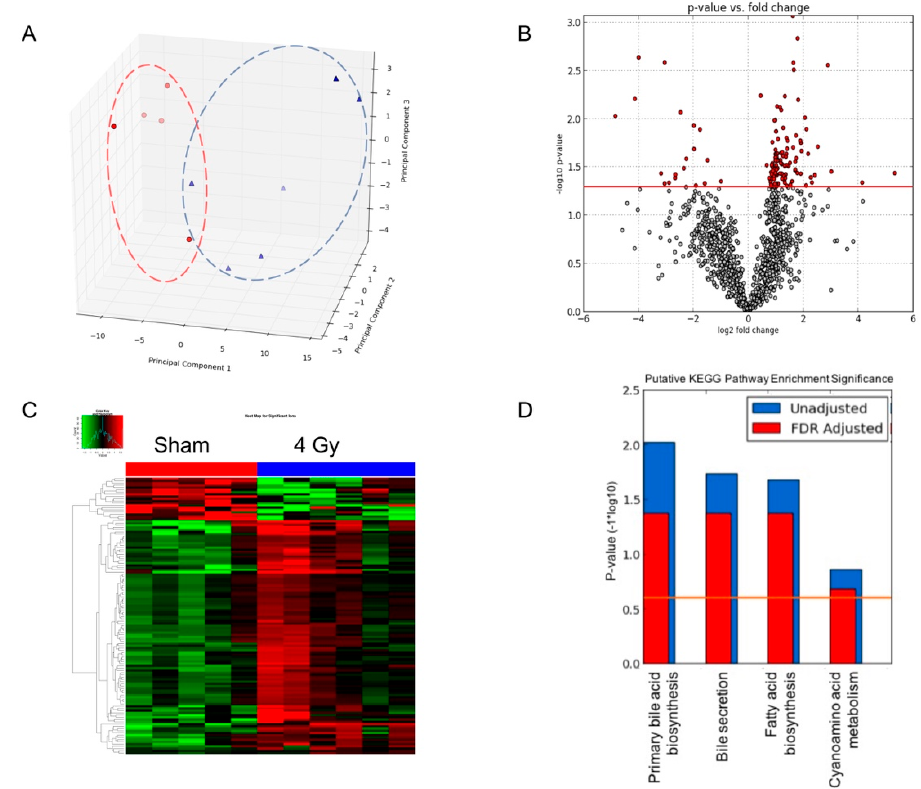
Figure 2. Comparative analysis of serum metabolomic profiles of control mice and those exposed to 137 Cs at a cumulative dose of 4 Gy with high dose rate. ( A ) The principal component analysis (PCA) plot showing separation of metabolomic signatures from 137 Cs-exposed (blue triangles) and control mice (red circles). ( B ) The volcano plot highlights statistically significant metabolites post-exposure (red dots). The p -value cuto ff is 0.05. ( C ) The heatmap of metabolites whose levels changed significantly. ( D ) Molecular pathway enrichment analysis results of the di ff erential ions identified in the multivariate analysis of serum metabolomic profiles.